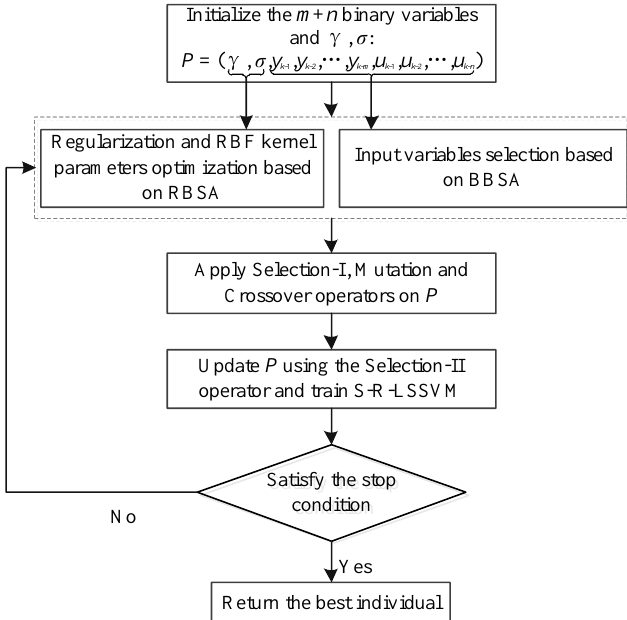
Figure 2. The optimization process of the hybrid backtracking search algorithm (HBSA) to optimize